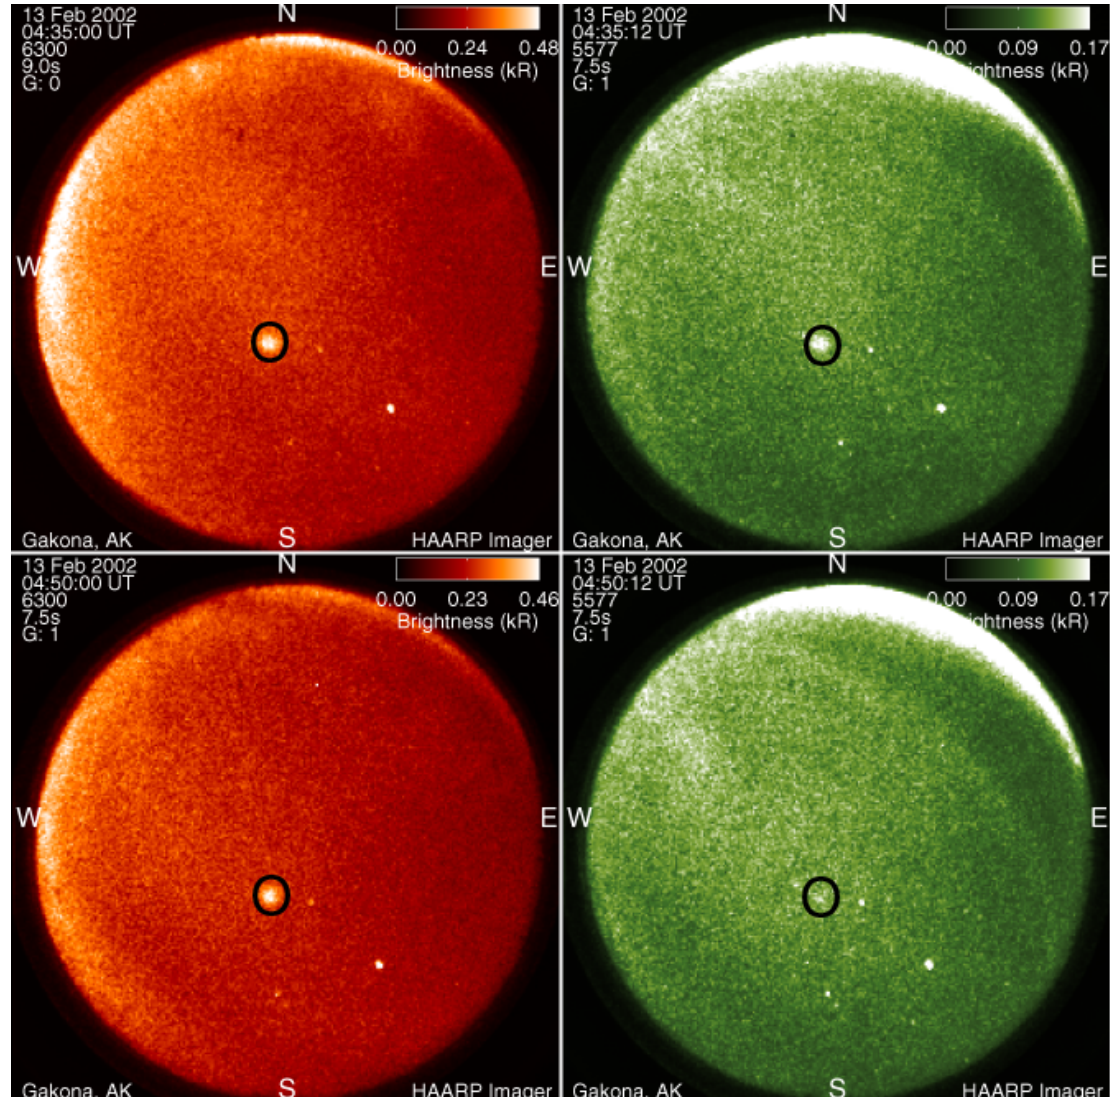
Fig. 3. Heater-induced red- and green-line emissions during the long pulse before (top) and after (bottom) fo F2 has dropped below f 0 . Bold circles mark the heated spot at MZ. Bright dots outside the circles are stars. The color bars show the brightness from 0 to 0.48kR and from 0 to 0.17kR for the red- and green-line emissions,